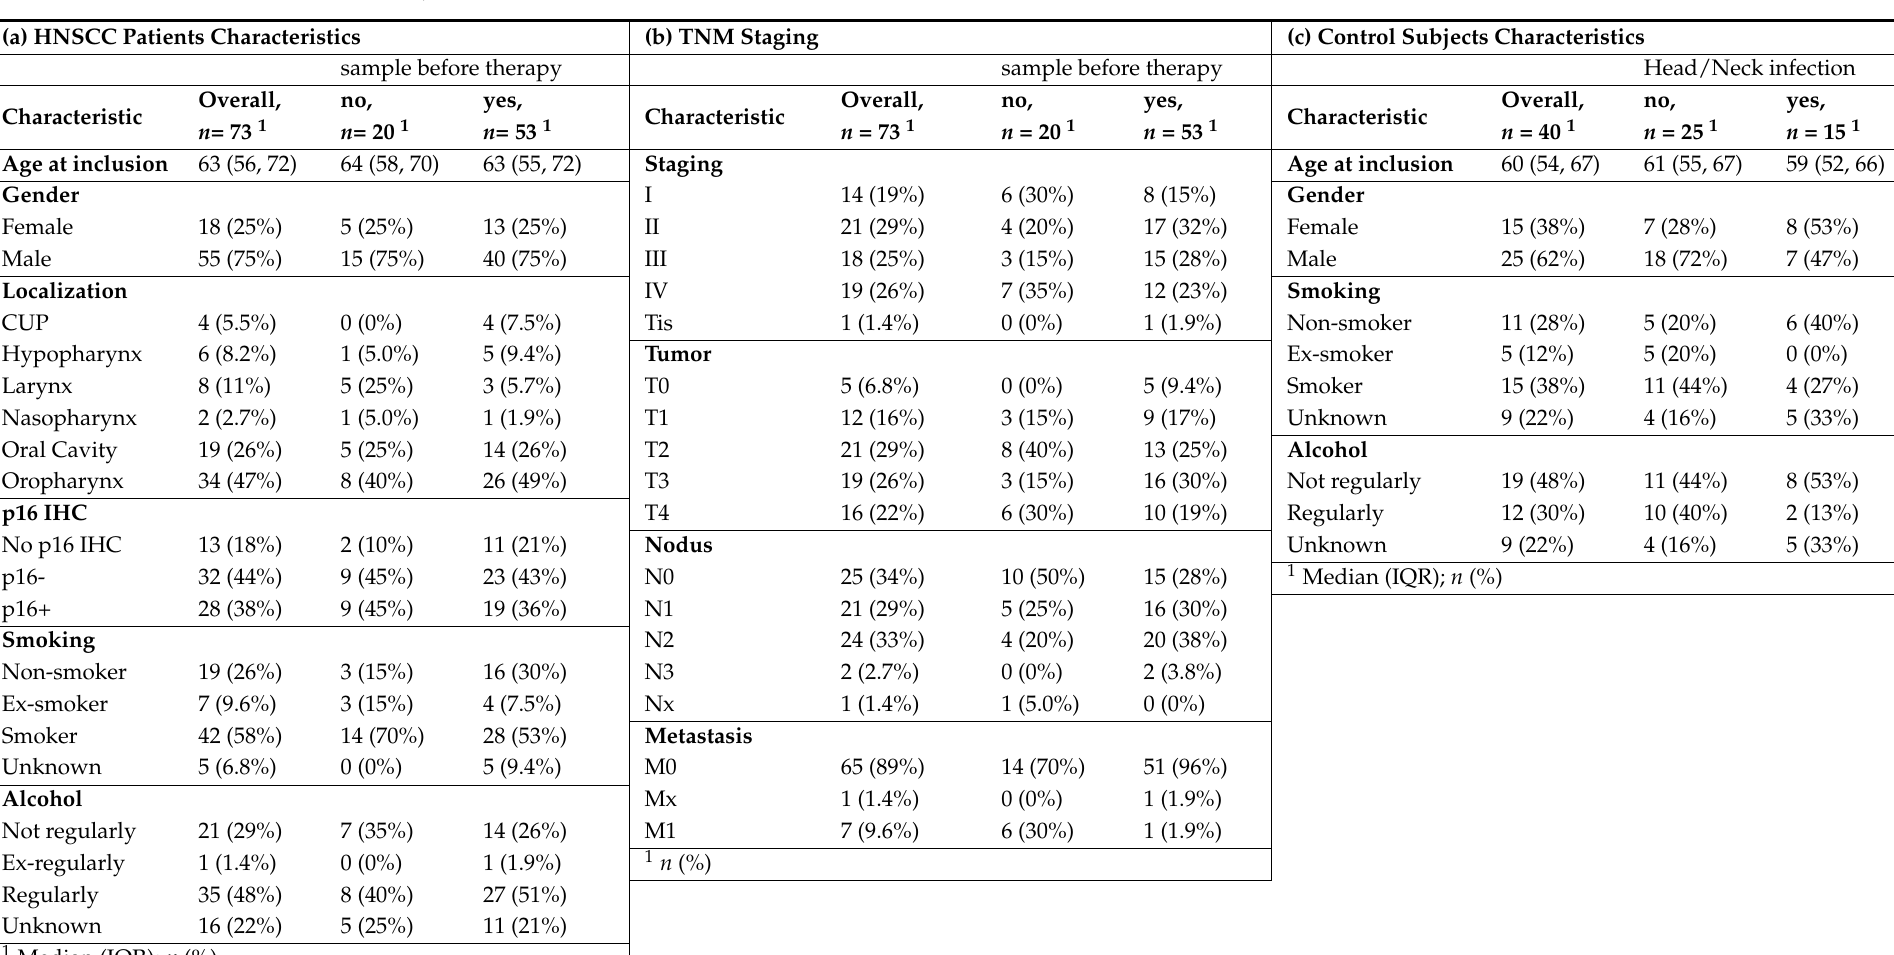
Table 1. ( a ) Clinical characteristics of HNSCC patients; ( b ) TNM-staging (according to UICC, 8th edition) of HNSCC patients; and ( c ) Clinical characteristics of control